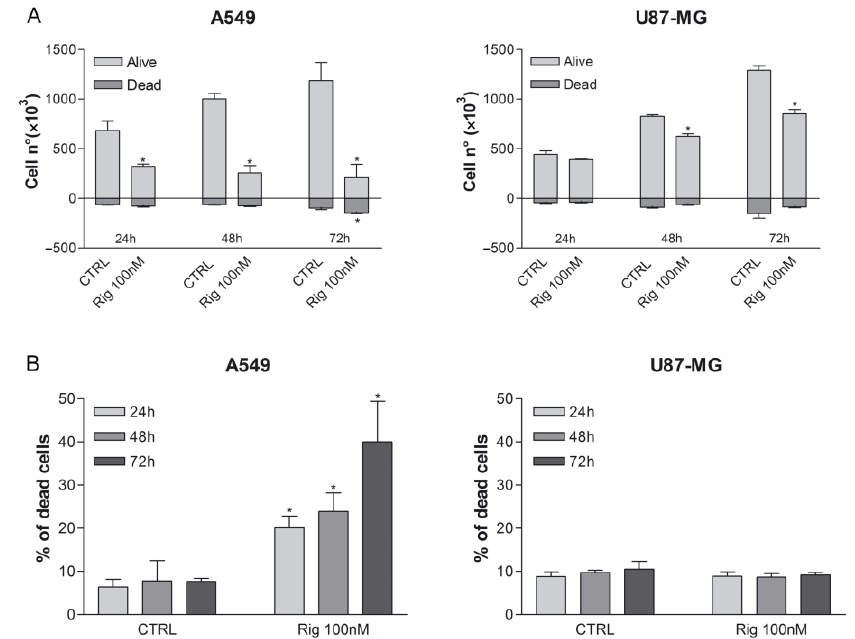
Figure 4. Evaluation of cancer cell viability and death after Rig treatment. ( A ) The number of viable and dead A549 and U87-MG cells, not treated (CTRL) or treated with Rig 100 nM for 24, 48, and 72 h, was evaluated by Trypan blue vital count assay. All the results are expressed as the mean ± SD of at least three independent experiments. * p < 0.05 vs. CTRL. ( B ) Percentage of dead A549 and U87-MG cells, not treated (CTRL) or treated with Rig 100 nM for 24, 48, and 72 h, was calculated on the results of Figure 3B. The percentage was calculated on the total of counted cells (arbitrarily set to 100%). * p < 0.05 vs. CTRL.